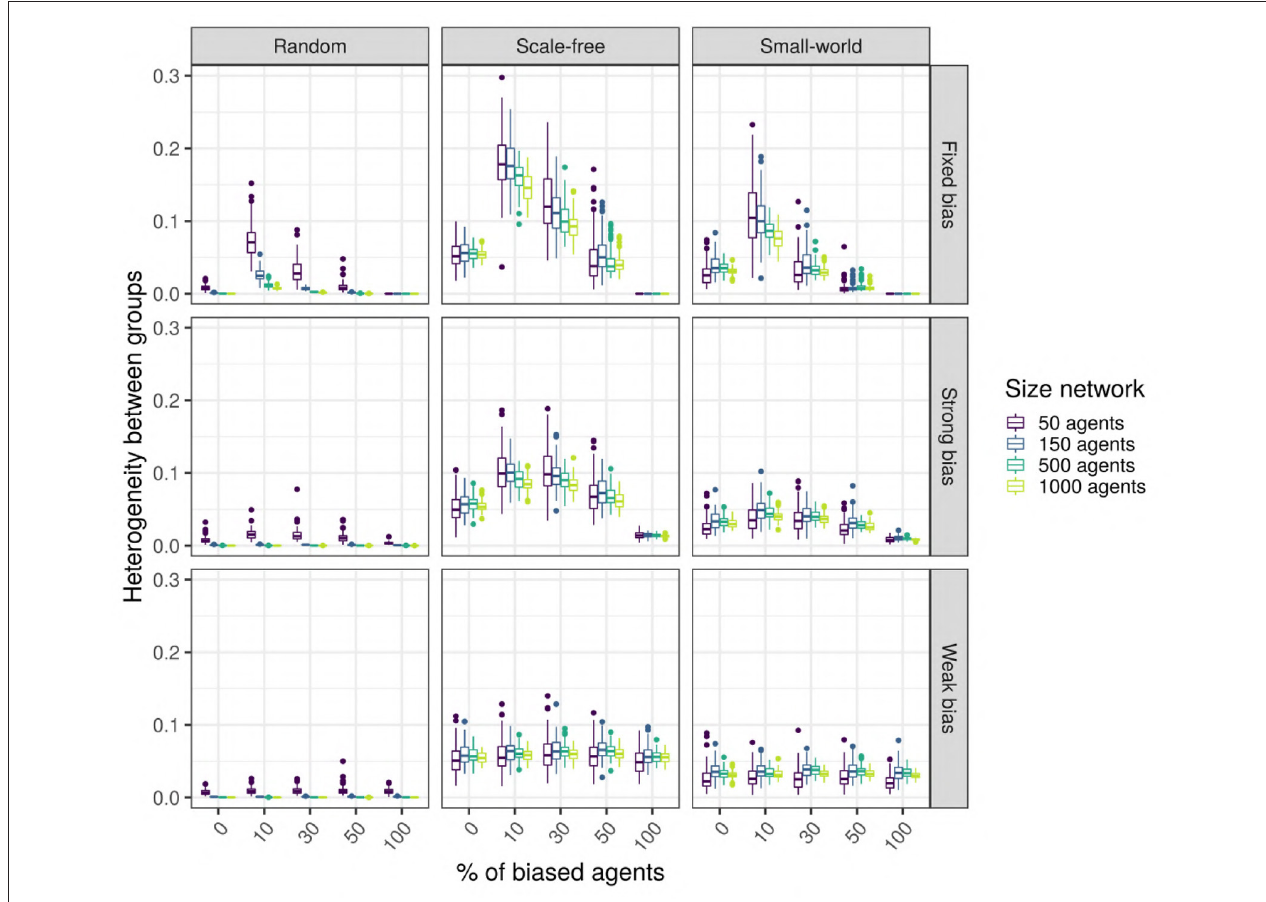
FIGURE 12 | The difference in heterogeneity between linguistic communities function of network type (columns) and size (colors), and bias strength (rows) and frequency (horizontal axis). The networks contain SAM agents, no influencers are biased, and there is an initial language. The adjusted p -values are almost always significant for